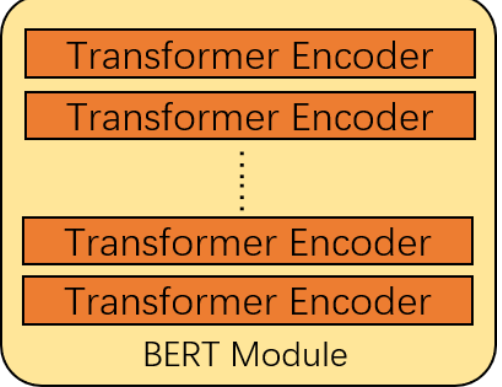
Figure 3. The framework of the BERT